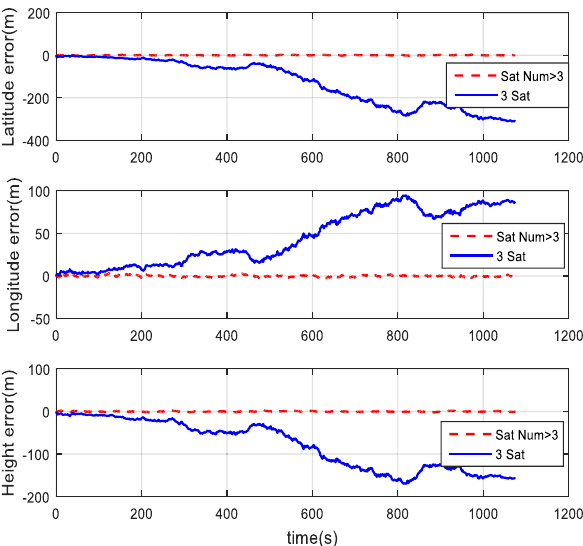
Figure 20. Position comparison of navigation by normal number of satellites and 3